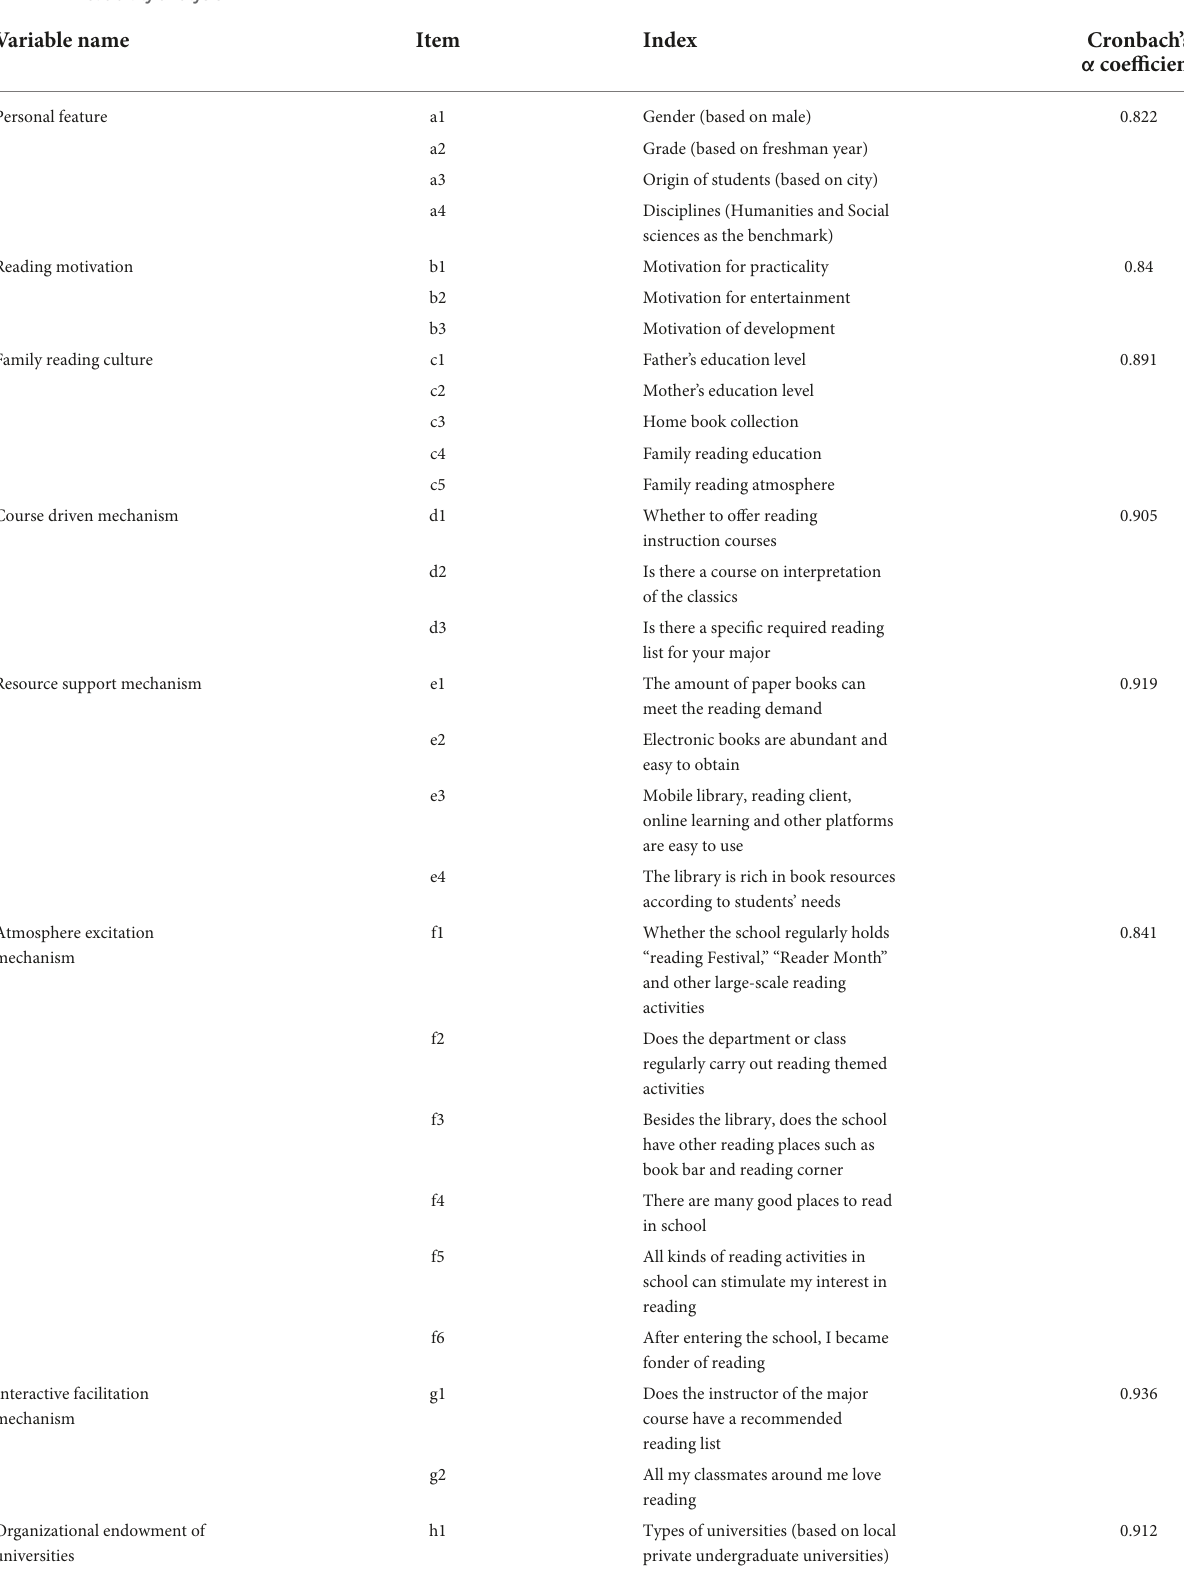
TABLE 4 Reliability